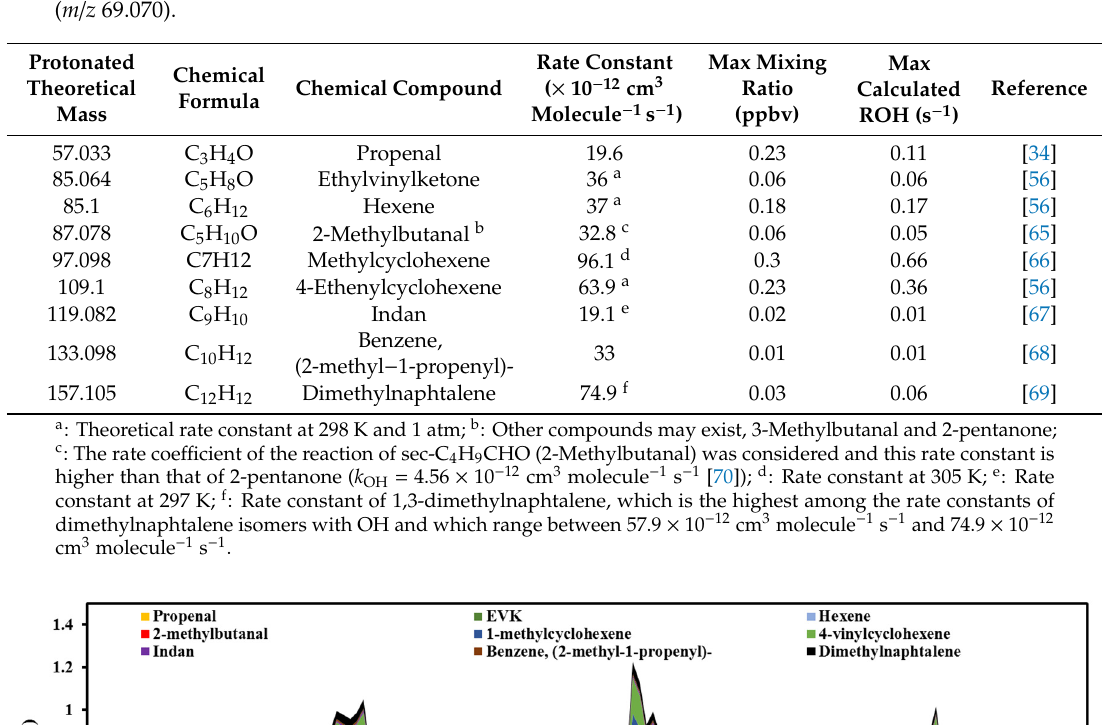
Table 4. List of the 9 selected masses which presented a correlation of 80% and more with isoprene ( m/z 69.070).